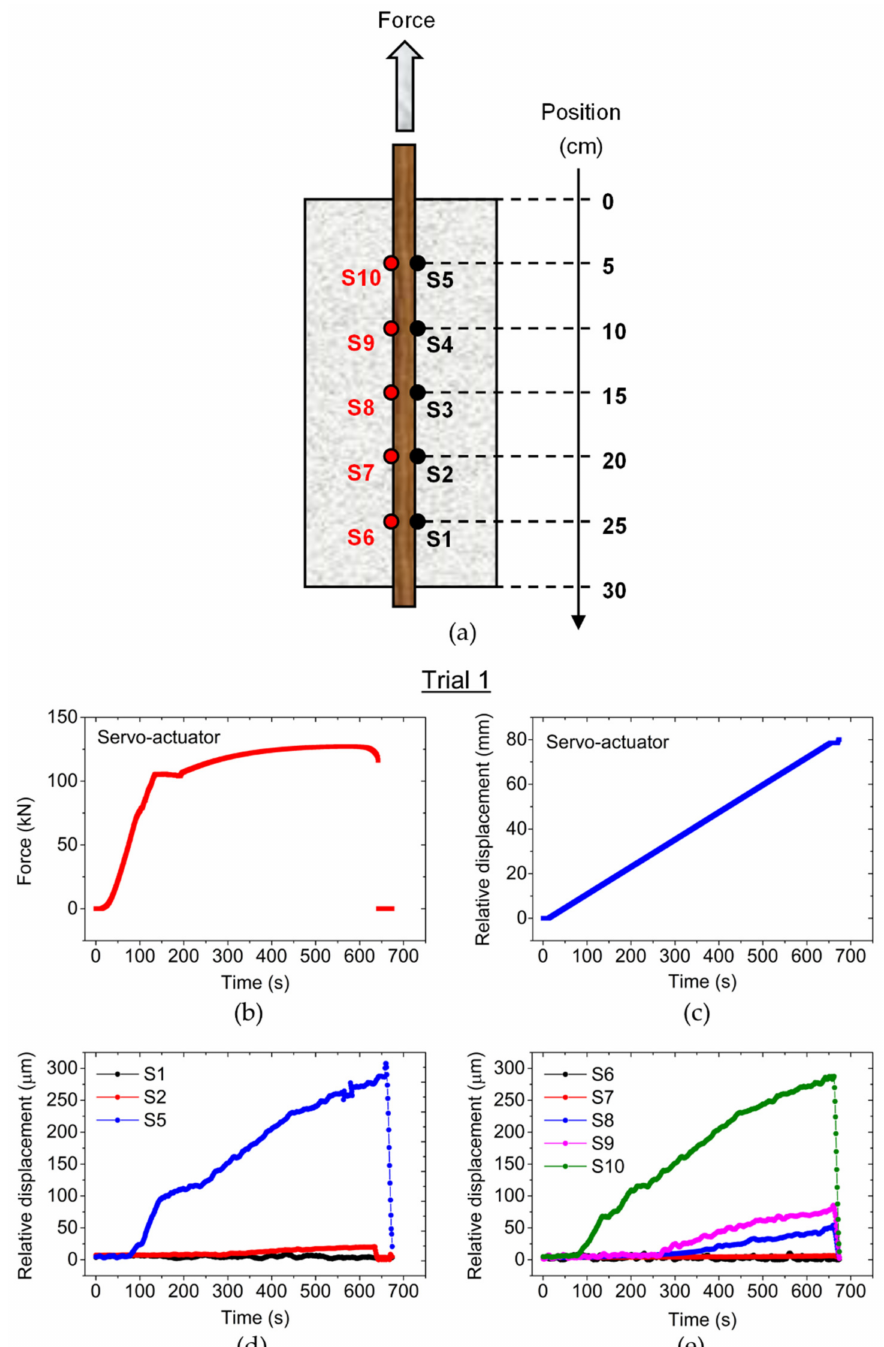
Figure 6. ( a ) Location of the optical sensors on RC sample. ( b ) Applied force to the RB during Trial 1. ( c ) Relative displacement from the servo-actuator. ( d , e ) Relative displacement measured by the optical sensors during Trial